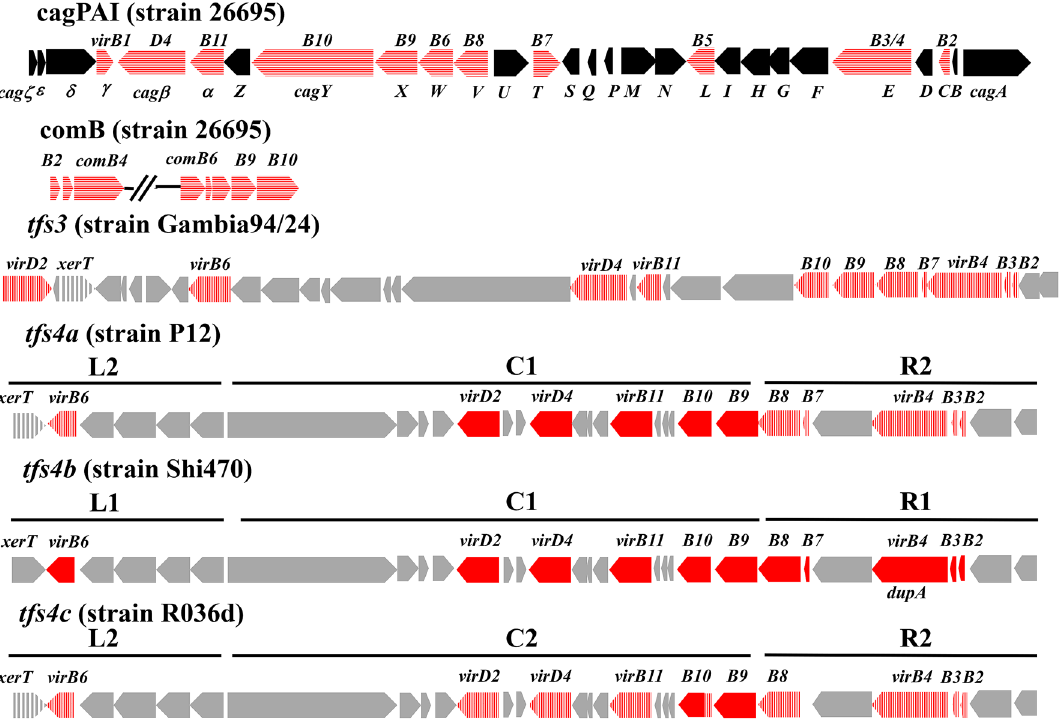
Figure 1. Gene arrangement of cagPAI, tfs3 , tfs4a , tfs4b , and tfs4c ICE, which were retrieved from H. pylori strain 26,695, Gambia94/24, P12, Shi470, and R036d, respectively. The red color indicates vir homolog T4SS genes in which nucleotide identity is more than 80% to corresponding genes of tfs4b ICE , while horizontal dashed red and dashed gray colors indicate that nucleotide identity was less than 80%, respectively, in a sequence comparison between tfs4b and others (Table 1 and Table S4). The black color indicates the other cag genes of cagPAI ( ζ, ε, δ, Z, U, S, Q, P, M, N, I, H, G F, D, B, A ). Gray color indicates accessory genes of tfs3 and tfs4 ICE, which included DNA processing genes ( xerT and topA ) and unknown function